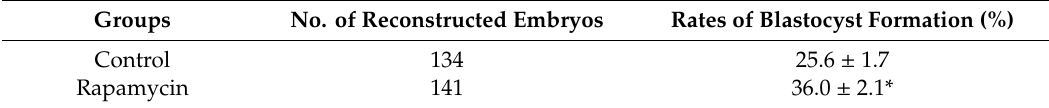
Table 2. Rapamycin addition promoted the formation of cloned